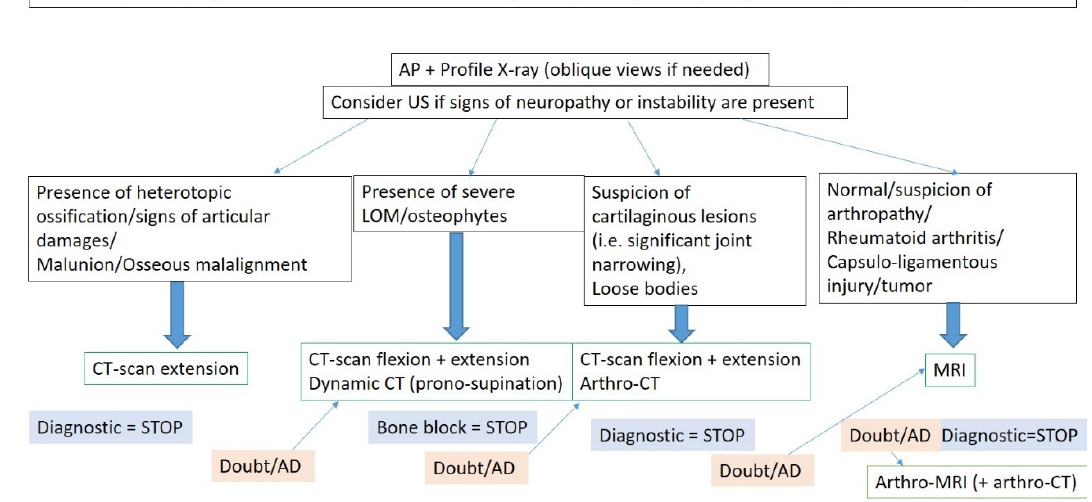
Figure 11. Diagnostic imaging studies prescription proposal. AD: alternative diagnosis; AP: anteroposterior; US: ultrasonography; LOM: loss of motion. The term doubt refers to an unsure diagnosis or a possible alternative diagnosis, requiring other imaging tests.